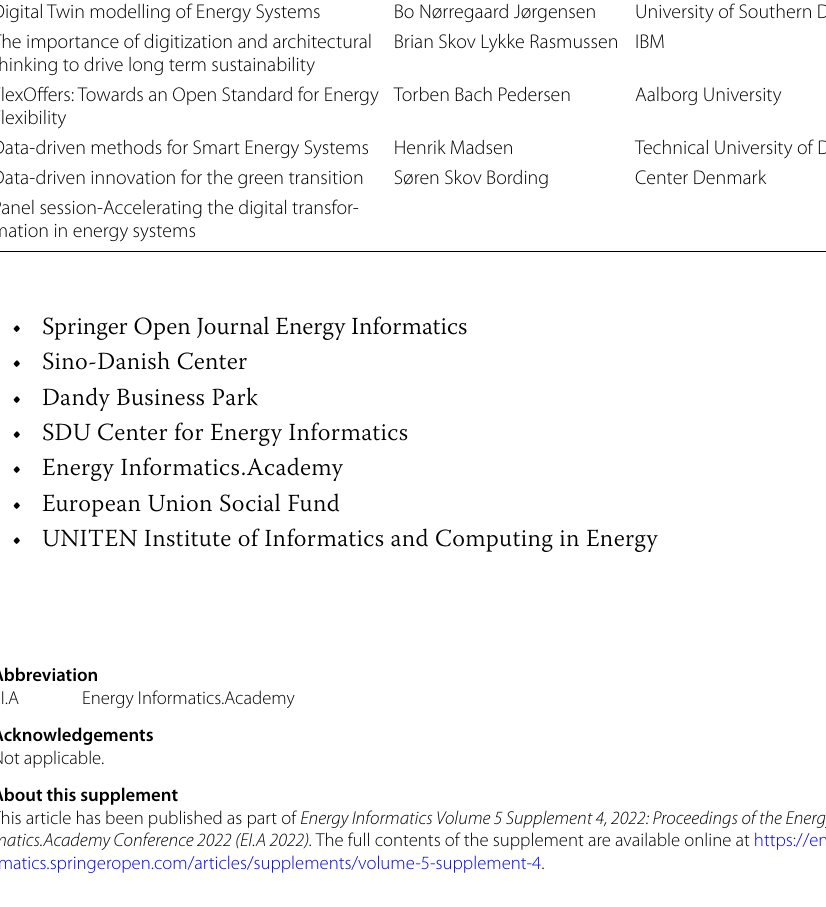
Table 2 Six keynote speeches at the Energy Informatics.Academy(EI.A) Asia 2021 conference Keynote speech